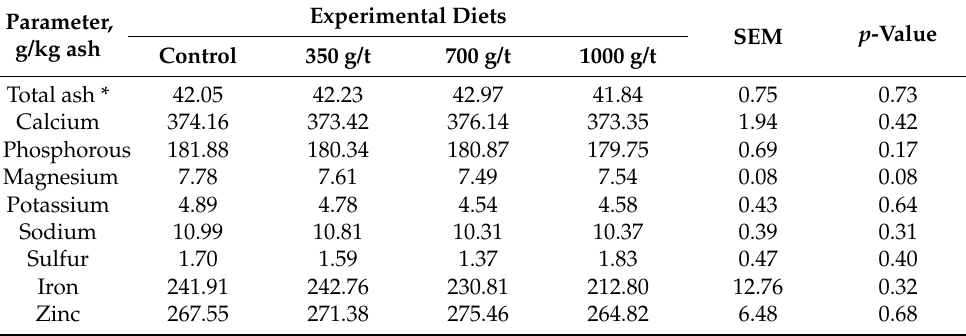
Table 8. Bone mineralization of 42-day-old broiler chickens fed with enzyme super-dosed diets. Experimental Parameter, g/kg ash